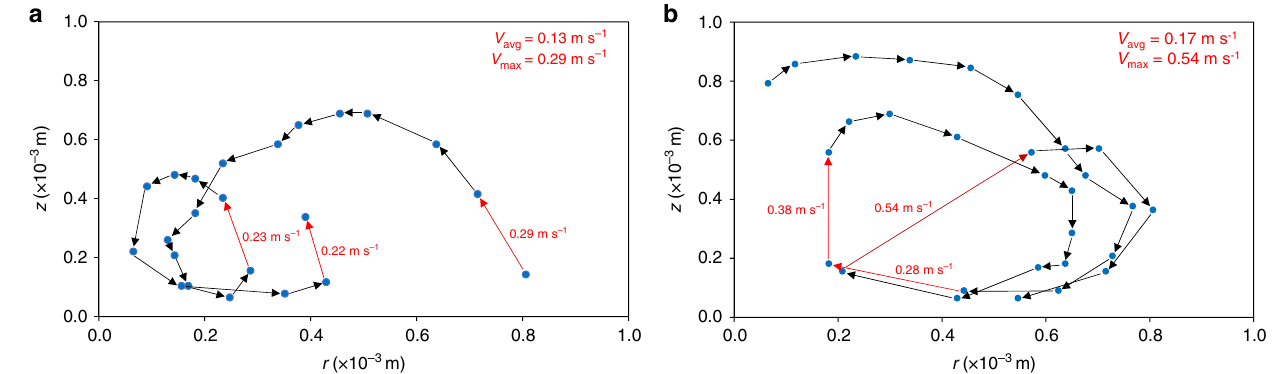
Fig. 5 Instantaneous particle velocity measurements in a low S steel, and b high S steel ~1 and 2 s after the inception of melting, respectively. r and z denote the distance in the radial and vertical axis,